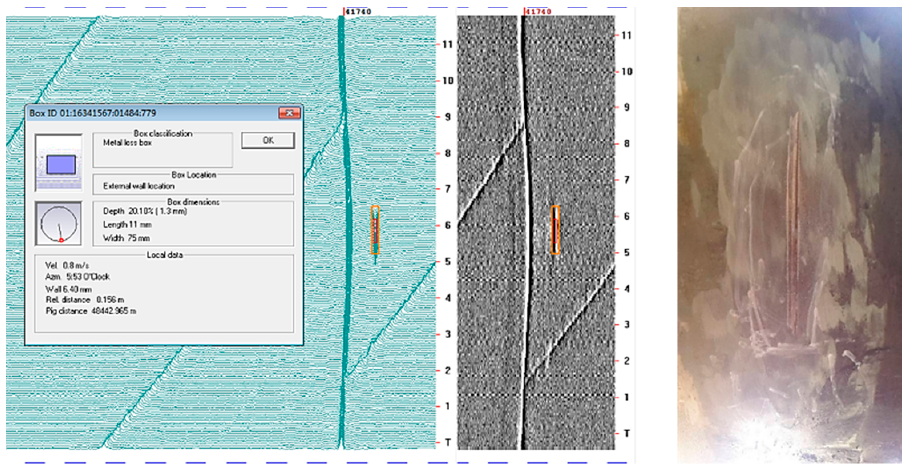
Figure 7. The metal loss signals caused by the manufacturing.